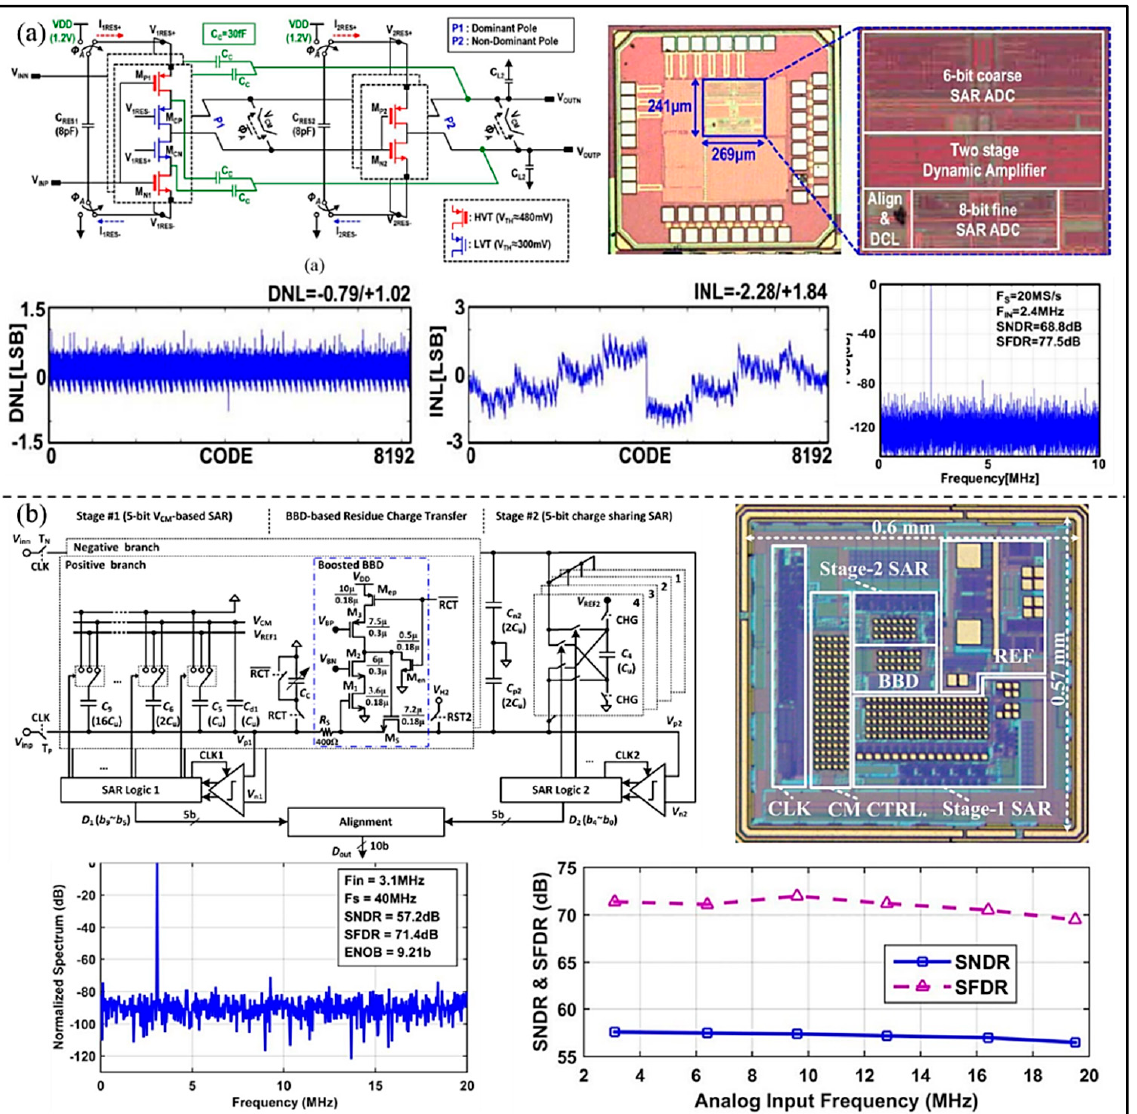
Figure 16. ( a ) The proposed chip microphotograph and frequency response comparison of ADC. (Reprinted from [63], Copyright 2021, with permission from IEEE); ( b ) Architecture of the proposed ADC, die microphotograph, and the measured performance. (Reprinted from [64], Copyright 2018, with permission from IEEE).